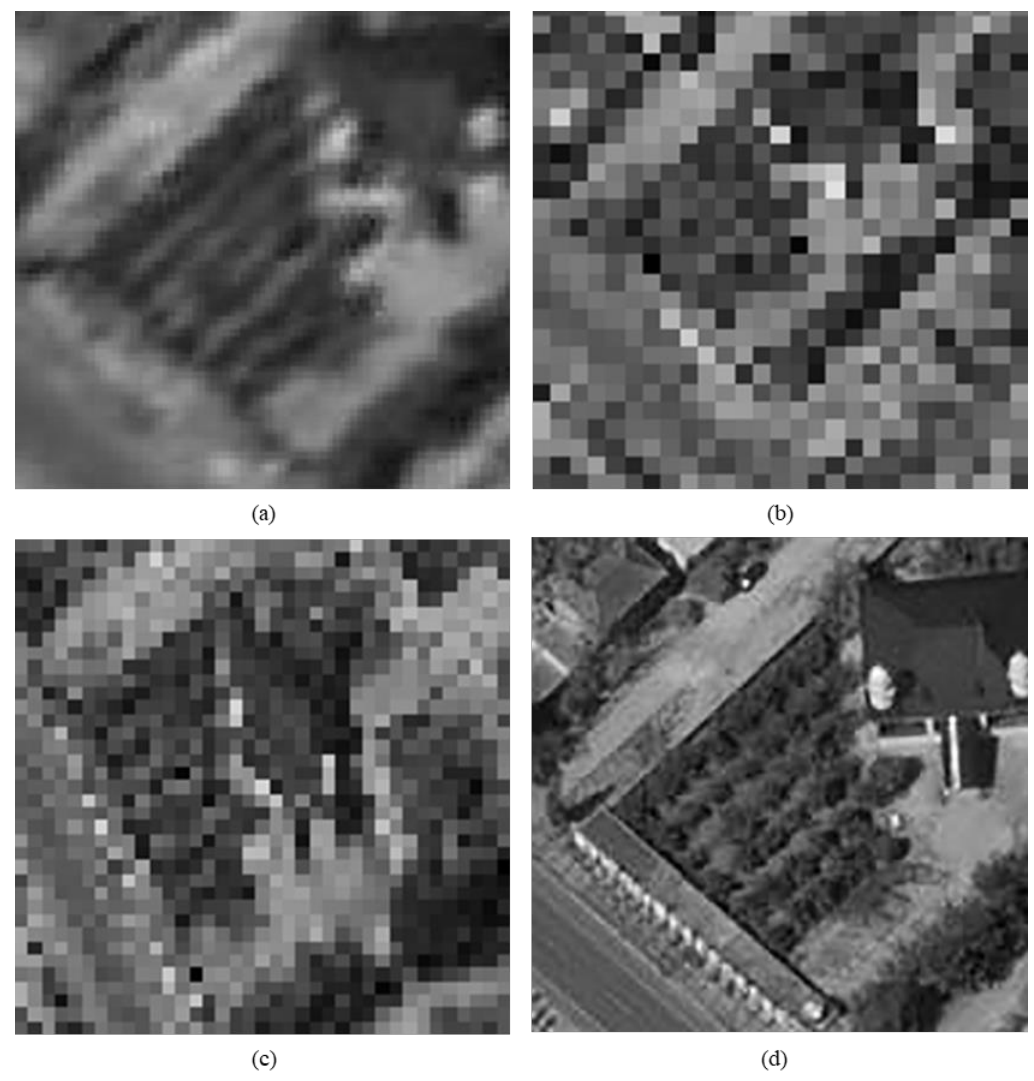
Figure 15. The local magnification of the farmland remote-sensing image: ( a ) super-resolution image, ( b ) conventional mode simulation image, ( c ) CMOS1 oblique-mode simulation images, ( d ) original high-resolution image.